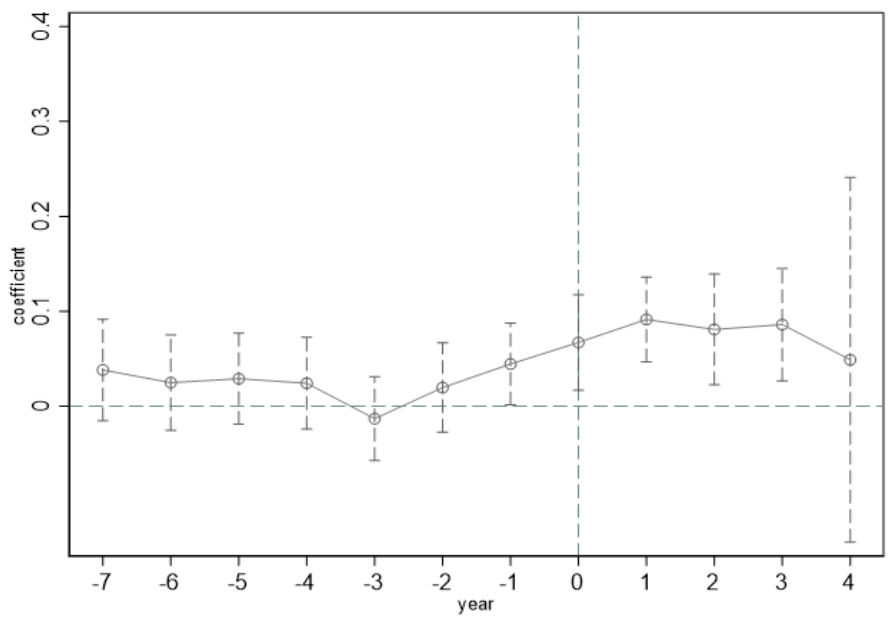
Figure 1. Parallel trend test results. Note: The x -axis represents the year before and after the construction of the NBDCPZ; − 7~ − 1 represent years before NBDCPZ implementation; 0 represents the current year of policy implementation; and 1~4 represent years after policy implementation. Table 2. Benchmark regression